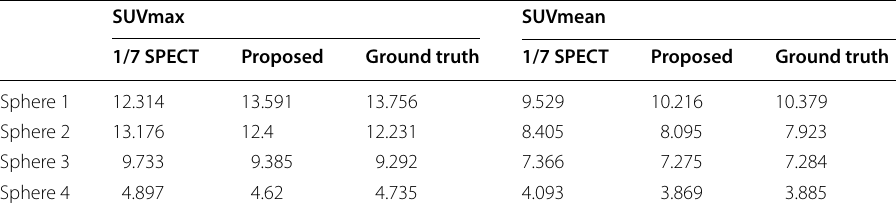
Table 2 Quantitative results for different spheres